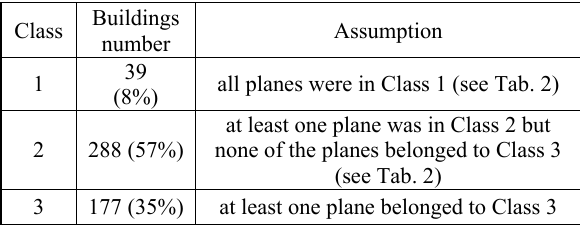
Table 3. The results of the qualitative assessment and the assumptions for LOD2 models for the Warsaw test